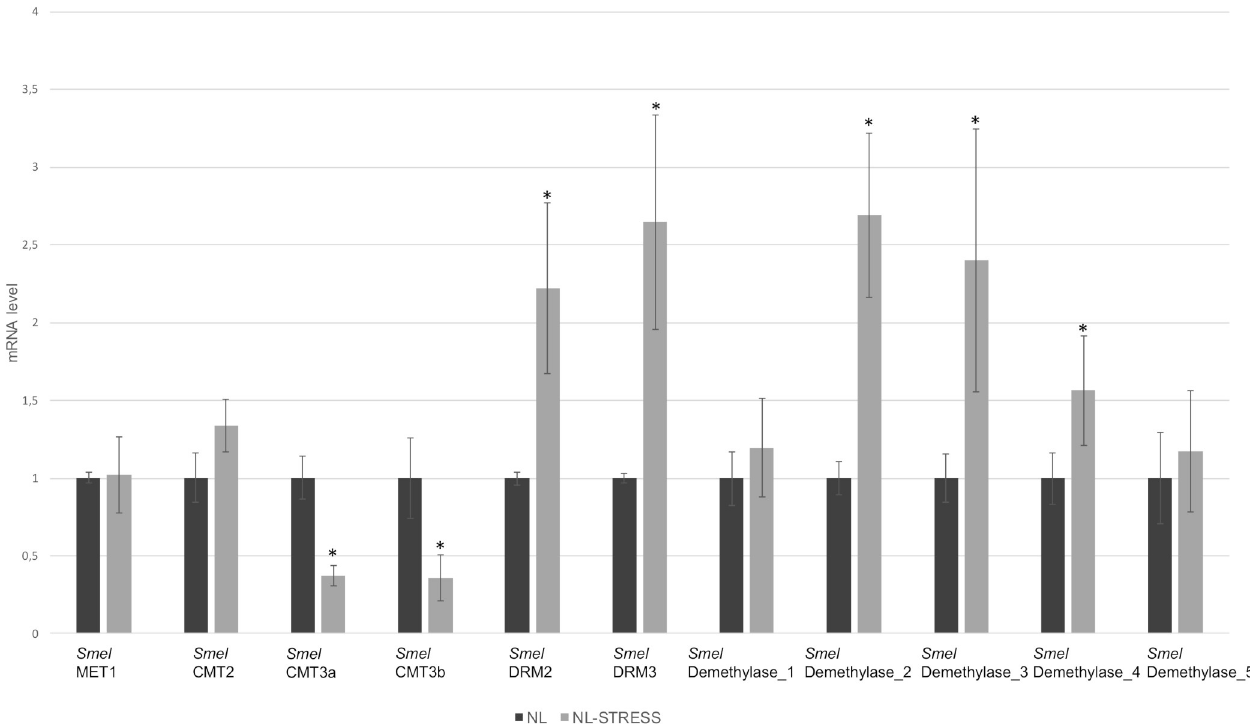
Fig 6. The patterns of expression of C5-MTase and DNA demethylase in leaf tissues of the F1 hybrid ‘Nite Lady’ in response to salt stress. The actin eggplant gene was used as the reference sequence. Error bars represent SD ( n = 3). Asterisk indicates a significant difference based on Tukey’s HSD (P � 0.05).